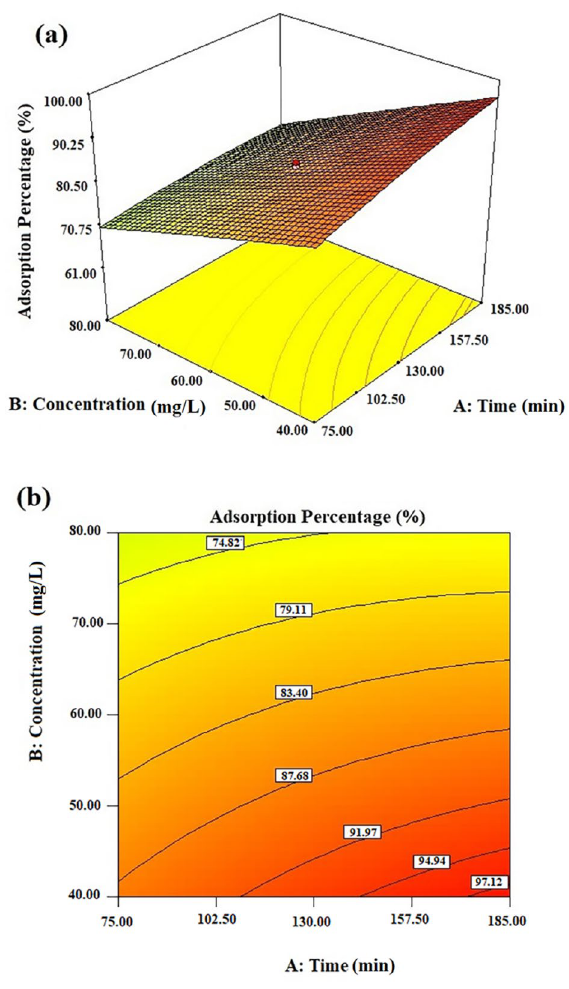
Figure 14. ( a ) 3D plot and ( b ) contour plot showing effect of concentration and adsorption time on percentage adsorption of cobalt(II) ions (pH = 4; gram of adsorbent = 0.06